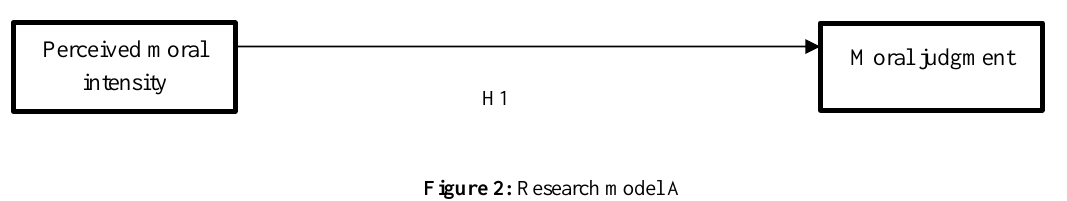
Figure 2: Research model